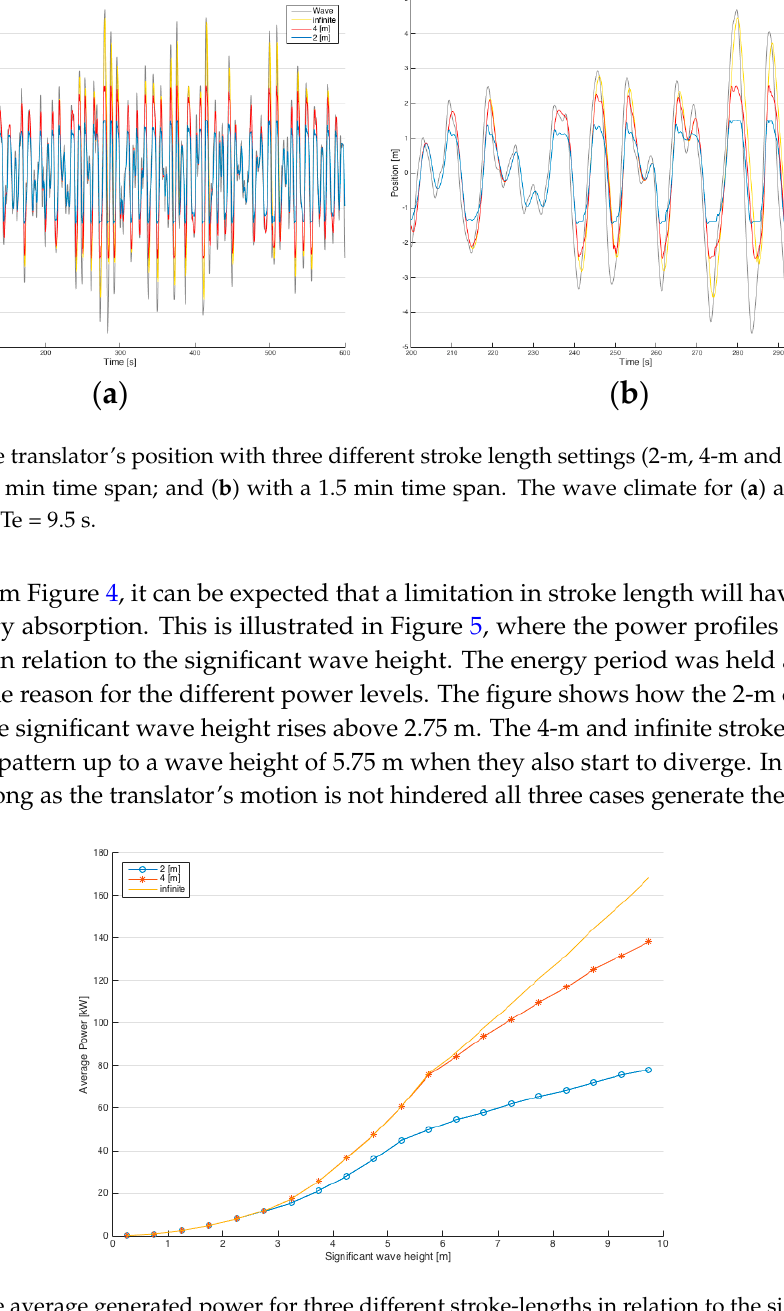
Figure 5. The average generated power for three different stroke ‐ lengths in relation to the significant wave height. The energy period is kept constant at 5.5 s.